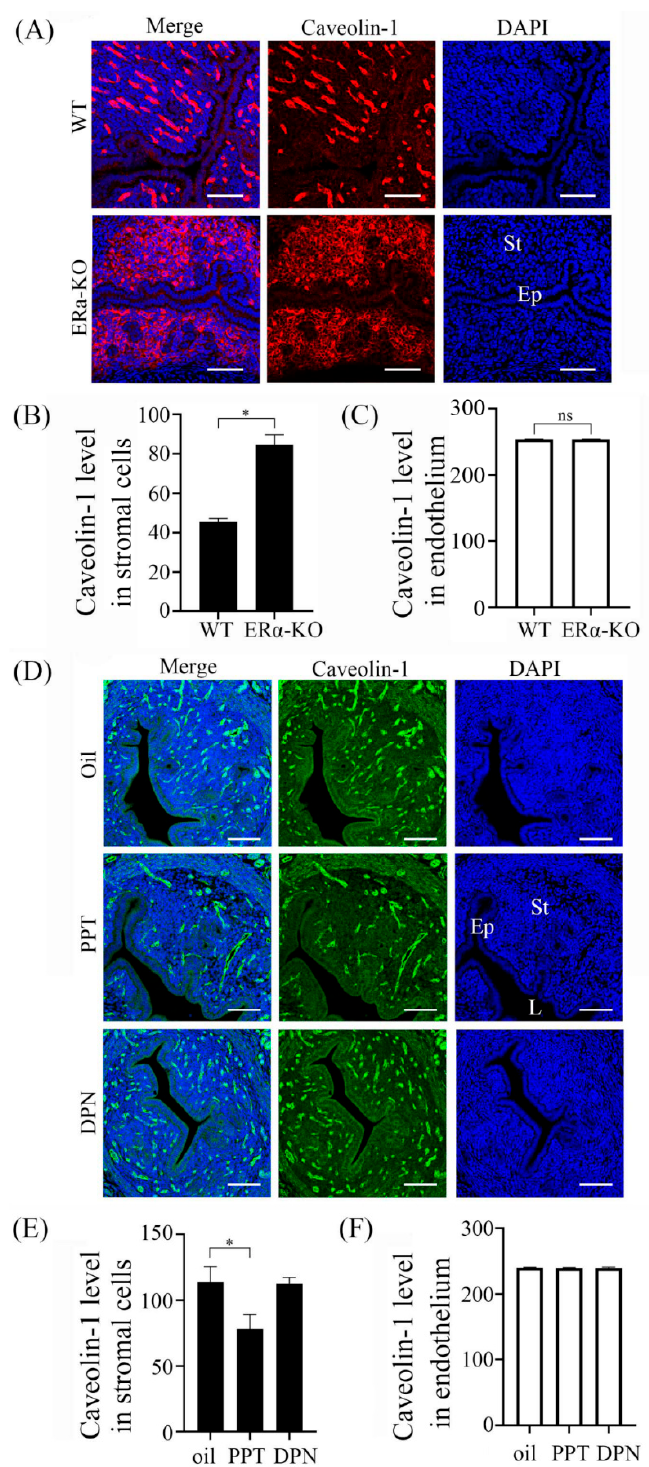
Figure 4. Caveolin-1 immunofluorescence in ovariectomized mouse uteri. ( A ) Mouse uteri from wild-type and ER α -KO mice, respectively. ( B ) Semi-quantitative Caveolin-1 level in endometrial stromal cells in ( A ). ( C ) Semi-quantitative Caveolin-1 level in endothelium in ( A ). ( D ) Mouse uteri treated with 100 mg PPT (agonist of estrogen receptor α ) or 50 mg DPN (agonist of estrogen receptor β ) and for 12 h. ( E ) Semi-quantitative Caveolin-1 level in endometrial stromal cells in ( D ). ( F ) Semi- quantitative Caveolin-1 level in endothelium in ( D ). Five mice per group. St, stromal cells; Ep, epithelium; L, uterine lumen; *, p < 0.05; ns, not significant; Scale bar = 100 um.